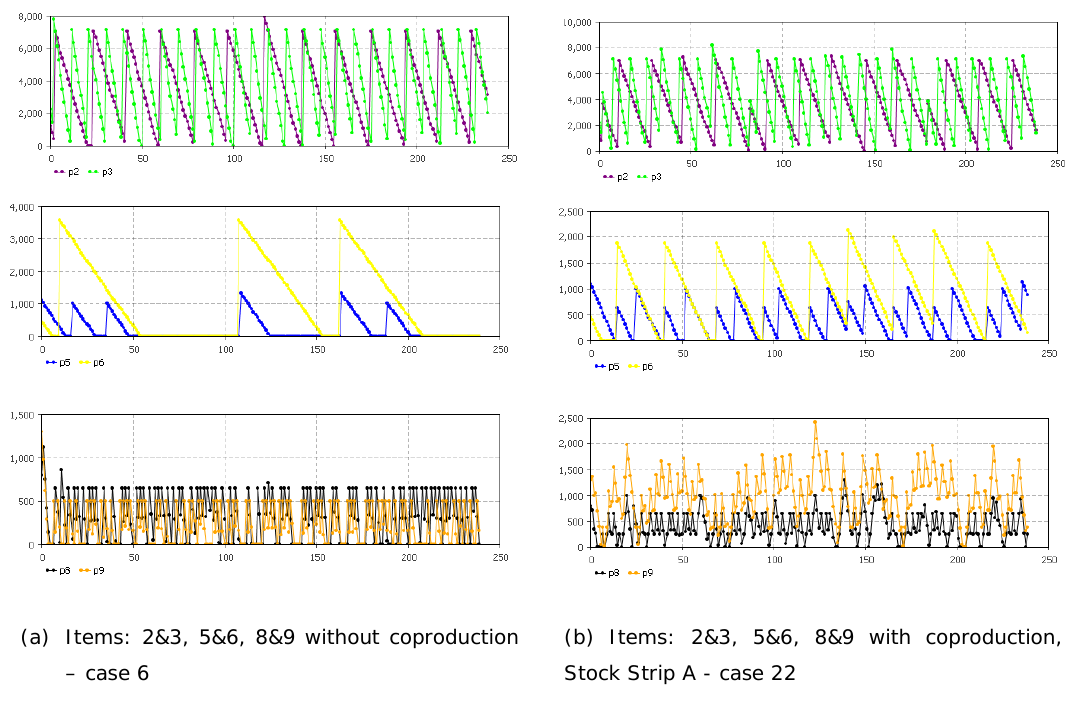
Figure 2. “Impact of Coproduction addition on stocks in the modified Doll and Whybark